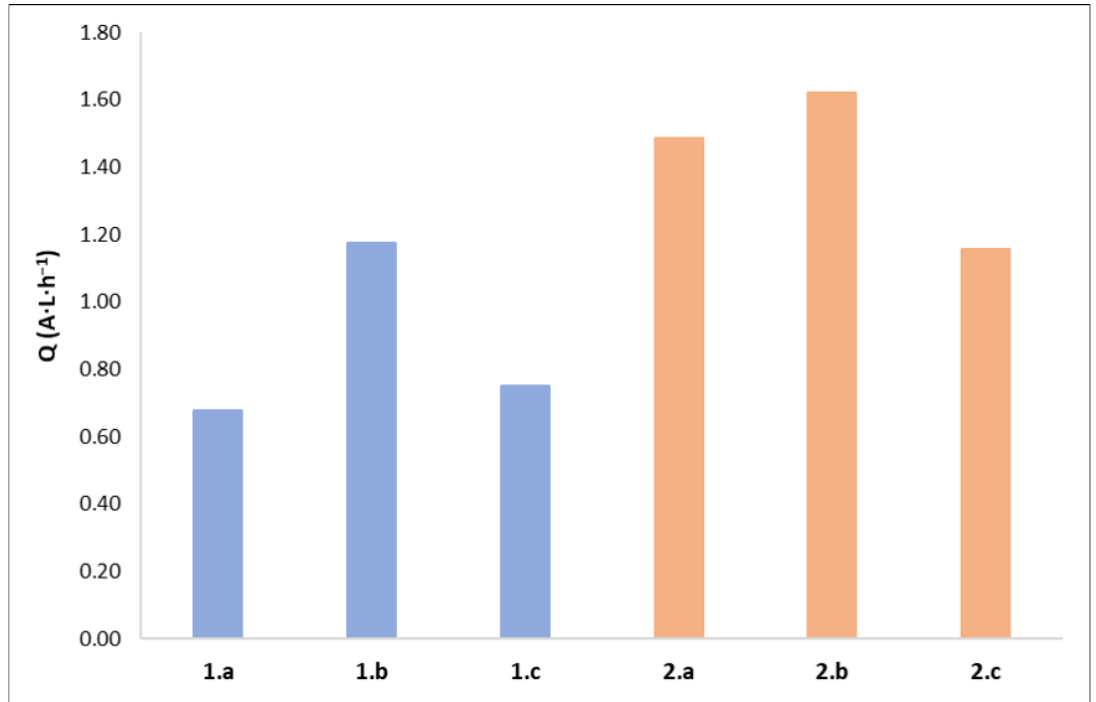
Figure 9. Comparison of Q required to achieve 85% decolouration by separately treating the ex- hausted dyebath and the first wash-off effluent or by mixing them before the treatment. Taking into account the necessary current value in each case, it is advisable to mix both effluents before the electrochemical treatment, especially when the dye concentration is